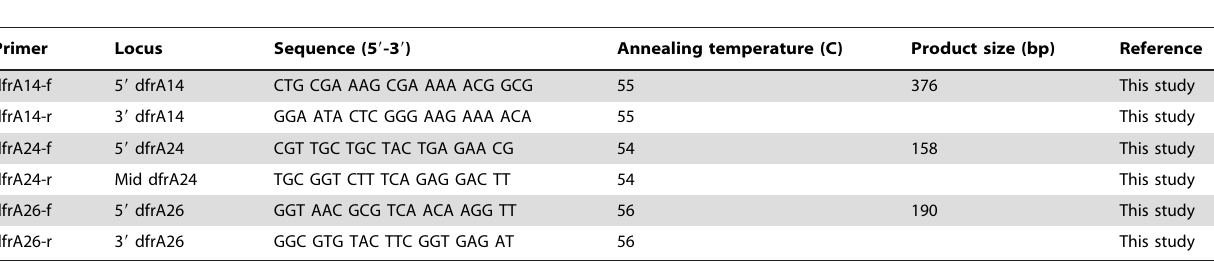
Table 1. Primers not previously published used in the PCR screenings.